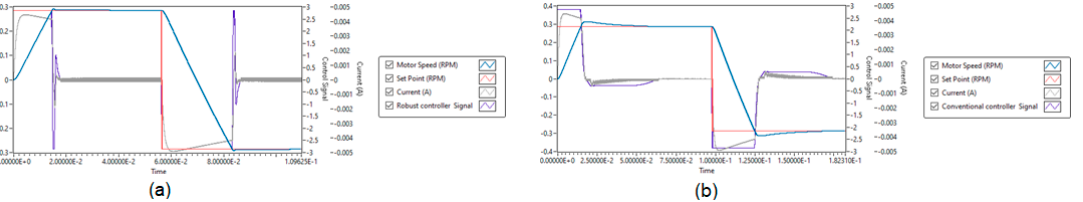
Figure 4. Robust controller ( a ) and conventional PID controller, ( b ) speed dynamic response (P.U.) when reference speed is changing direction from 0.28 PU to -0.28 P.U; time in seconds.